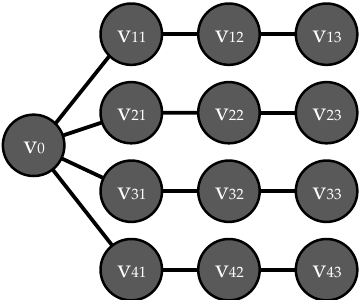
Figure 1. A “star” type structure with 4 rays of length 3.